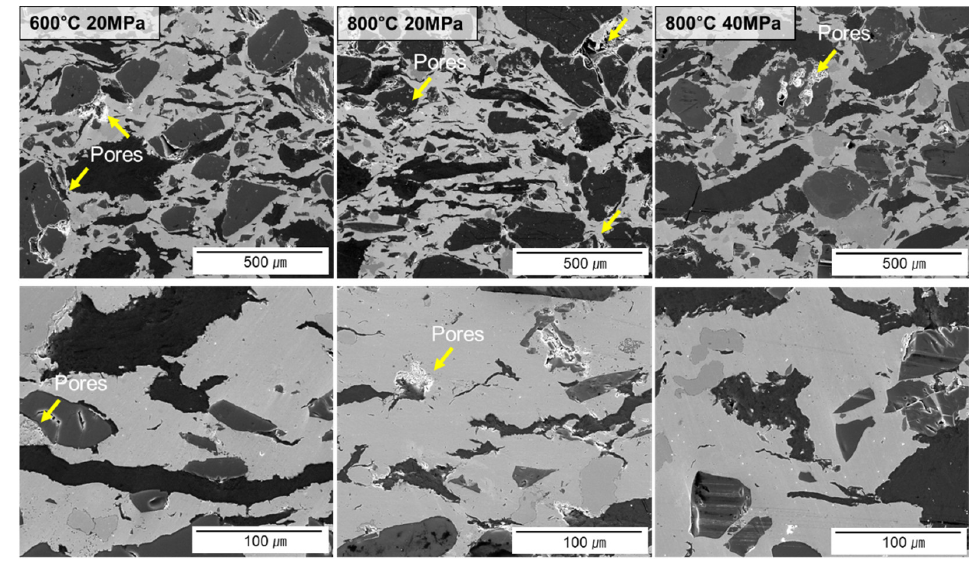
Figure 3. SEM images of cross-sectional microstructure of 600-20, 800-20, and 800-40 samples.